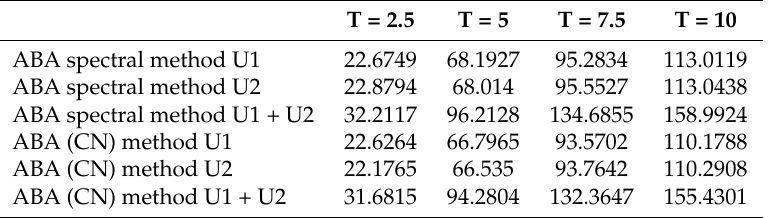
Table 10. Computational errors of two solitons in spinor system.